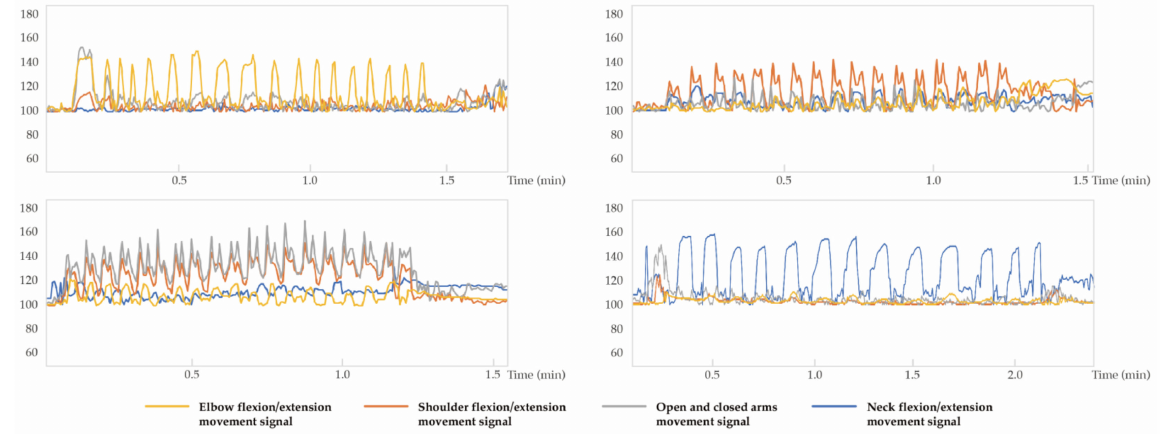
Figure A1. The processed signals of the four movements from the textile